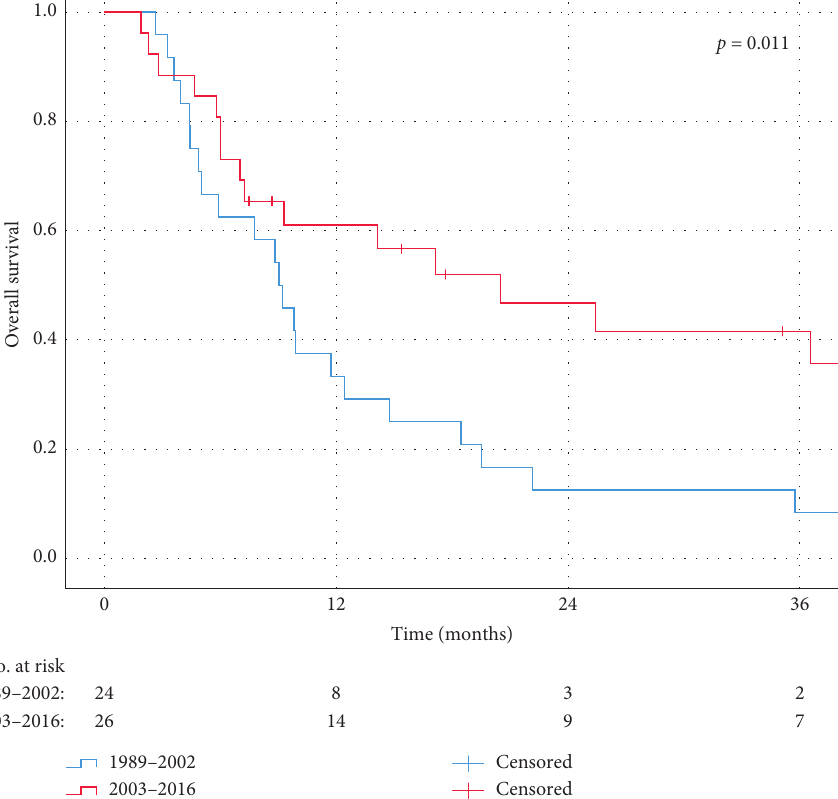
Figure 3: Kaplan–Meier curves representing OS of patients with primary metastasized disease in the period of 1989–2002 vs. 2003–2016, as compared by the log-rank test ( p � 0 .